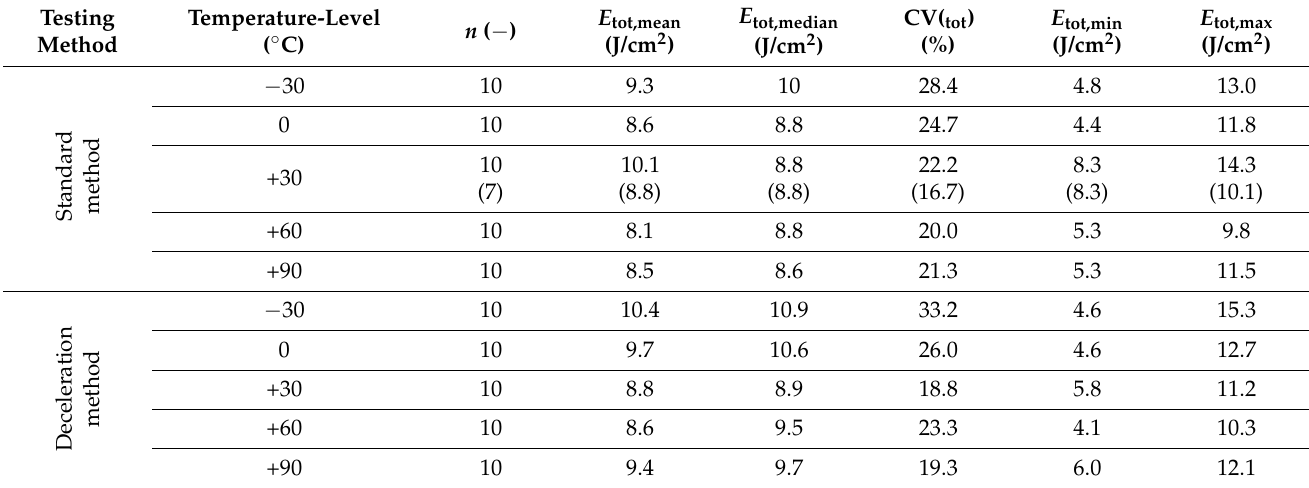
Table A1. Essential statistics of birch according to the standard method and the deceleration method: mean impact bending energy ( E tot,mean ), median impact bending energy ( E tot,median ), coefficient of variation of the impact bending energy (CV( tot )), minimum impact bending energy ( E tot,min ) and maximum impact bending energy ( E tot,max ). Values in parentheses are statistics without invalid results.